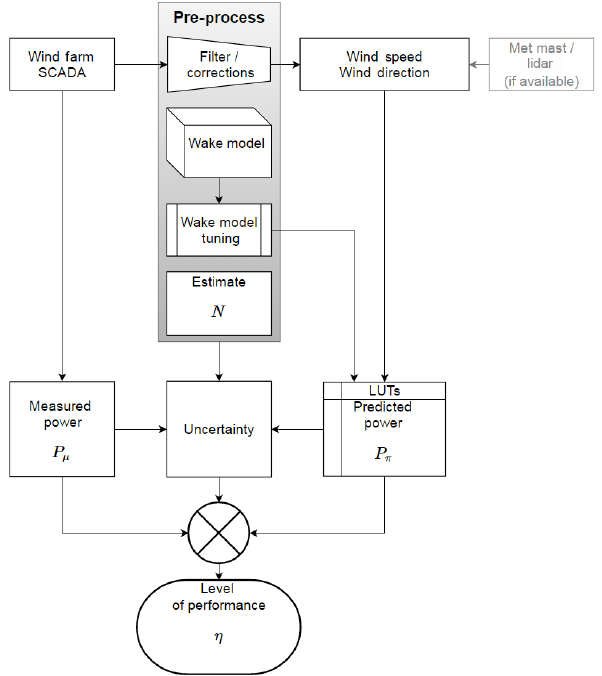
Figure 1. Flowchart of the performance monitoring model. Wind speed and wind direction are derived from SCADA data after an offset correction of each wind direction signal and outlier filtering. Wake model calculations and tuning as well as the estimation of the number N of 10min samples for averaging are preprocessed. N , P π and P µ are input values for the uncertainty calculation. An underperformance indicator η lower than the uncertainties indicates